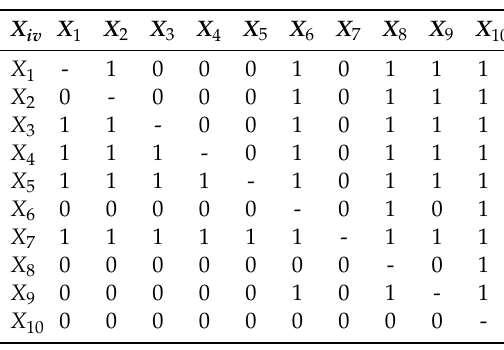
Table 9. The priority relationship between